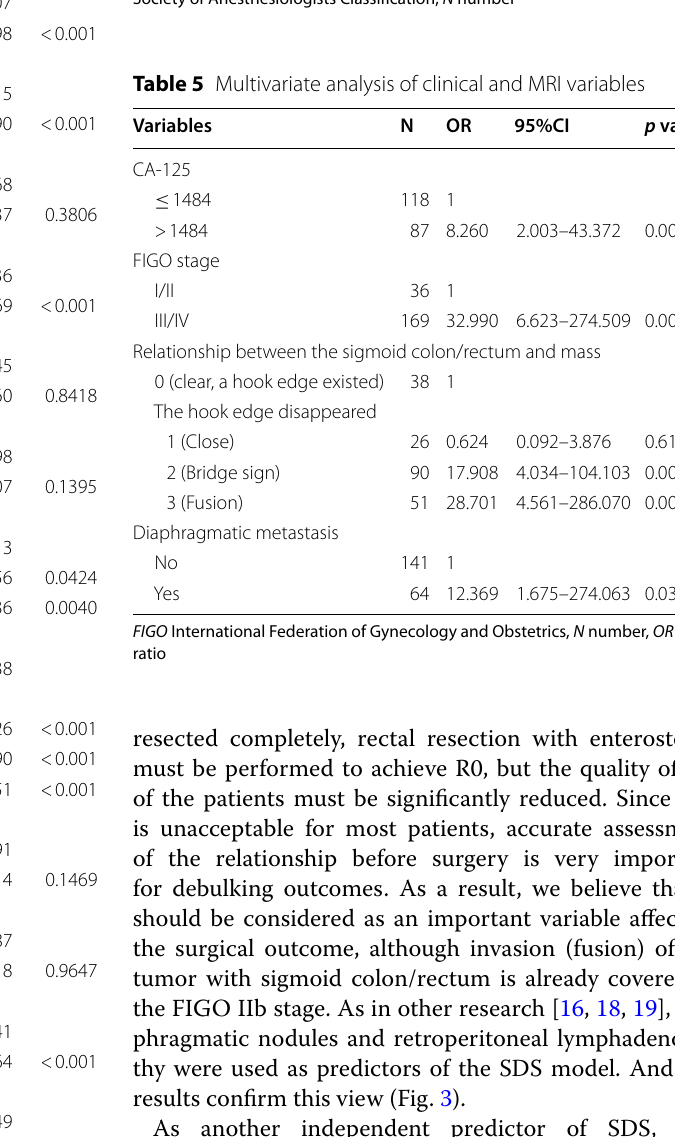
FIGO International Federation of Gynecology and Obstetrics, ASA American Society of Anesthesiologists Classification, N number